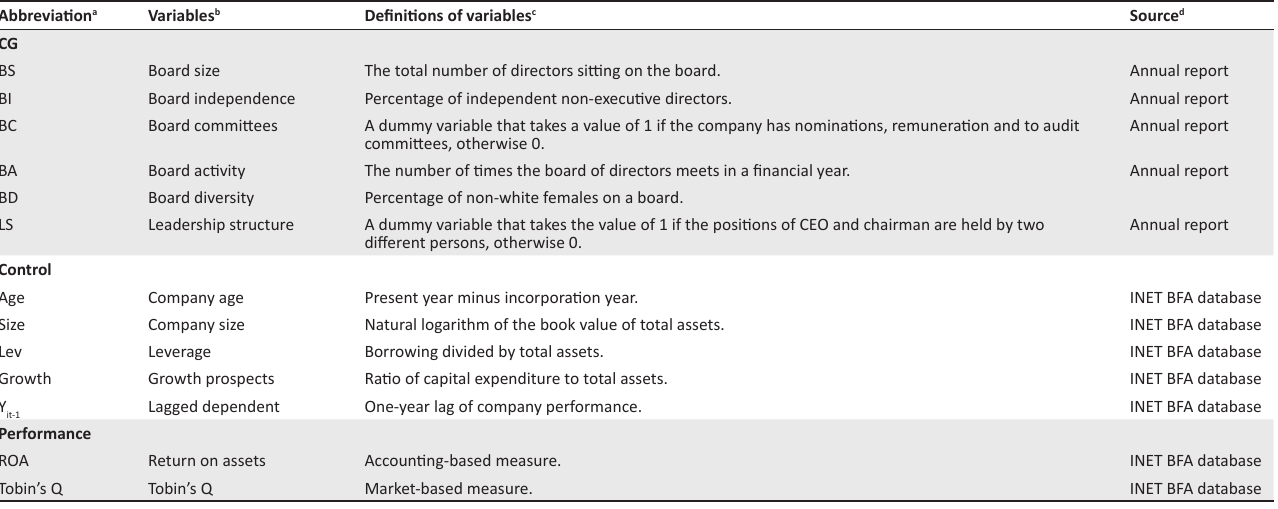
TABLE 1: Description of variables used in the study. Abbreviation